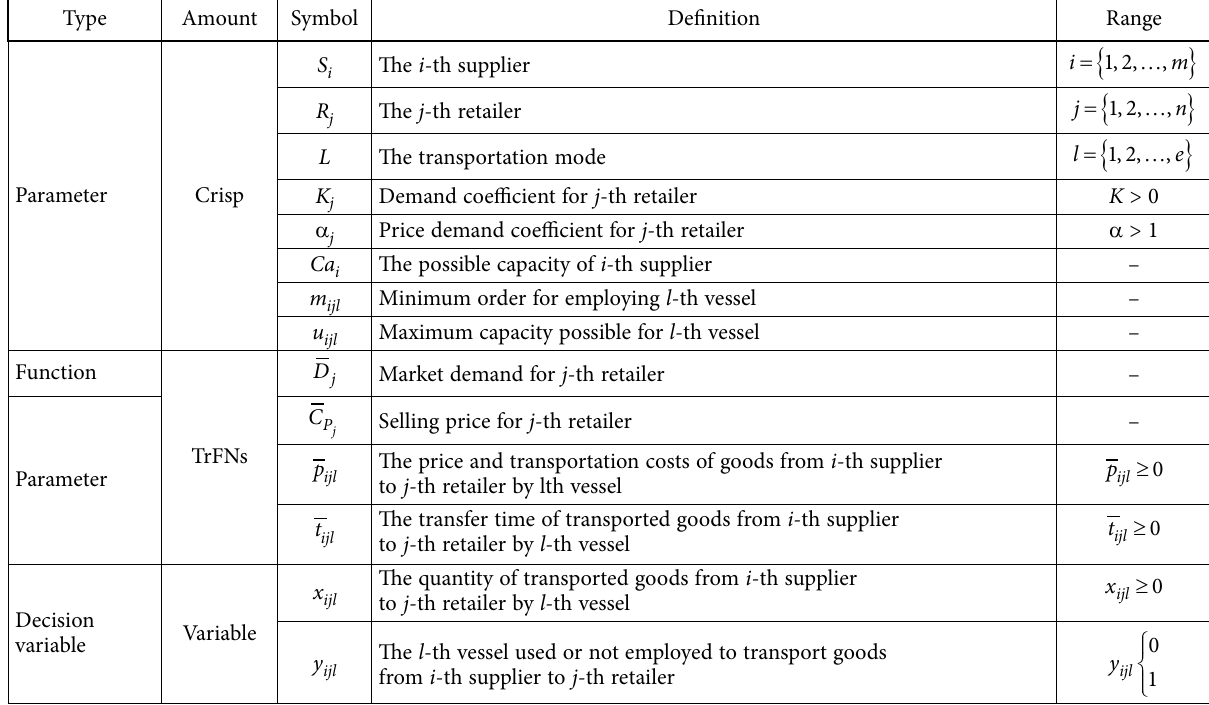
Table 1. Model parameters and variables